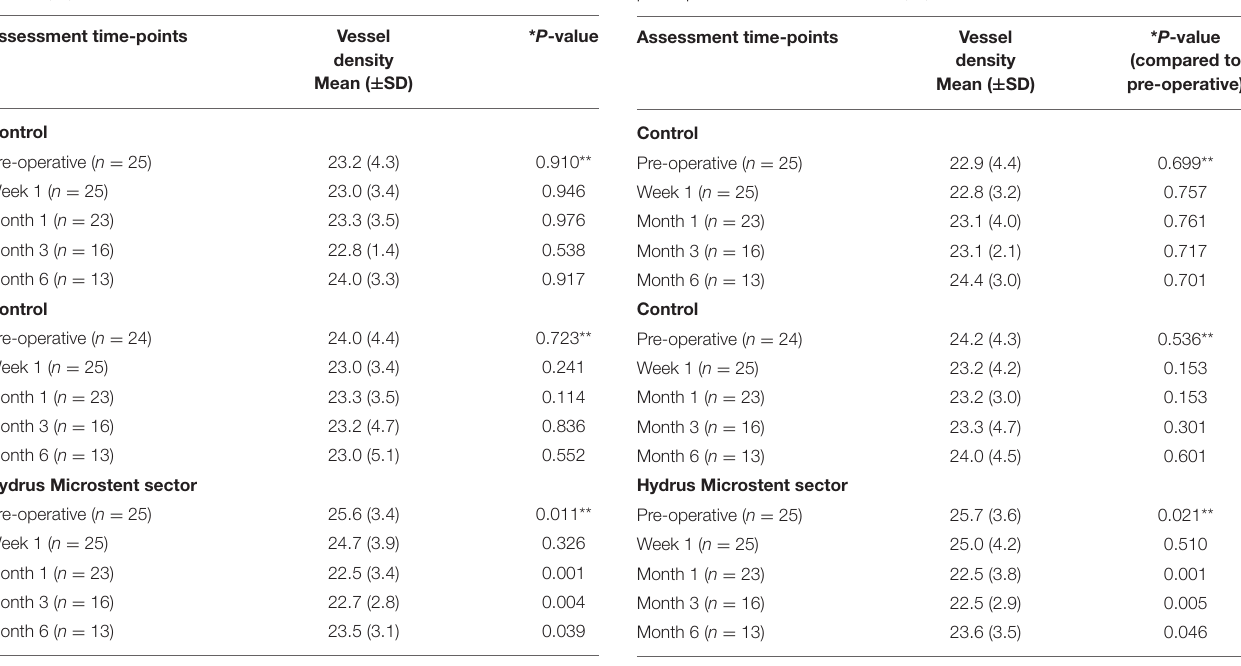
TABLE 2 | Optical coherence tomography angiography vessel density measurements of overall vasculature (conjunctival, episcleral, scleral) in sectors with Hydrus Microstent implants and controls comparing pre-operative and post-operative week 1 and month 1, 3, and